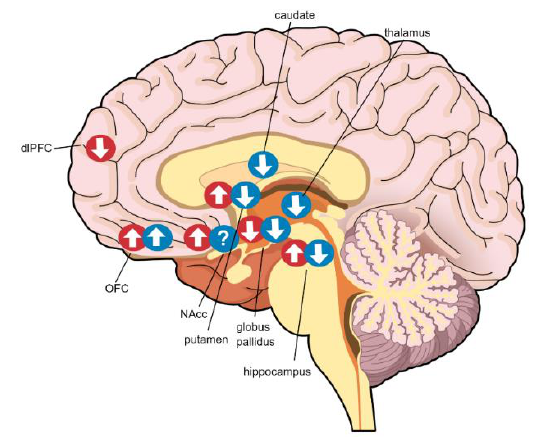
Figure 1. Gray matter volume differences in obesity by sex/gender. Red circles indicate changes among females and blue circles indicate changes among males. Arrows indicate the direction of the correlation between gray matter volume and obesity metrics (i.e., BMI, total body fat, serum leptin). dlPFC: dorsolateral PFC; OFC: orbitofrontal cortex; NAcc: nucleus accumbens.